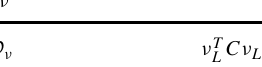
Table 8 LEFT operators in the San Diego basis. The third column lists the number of operators in the category whereas the last column